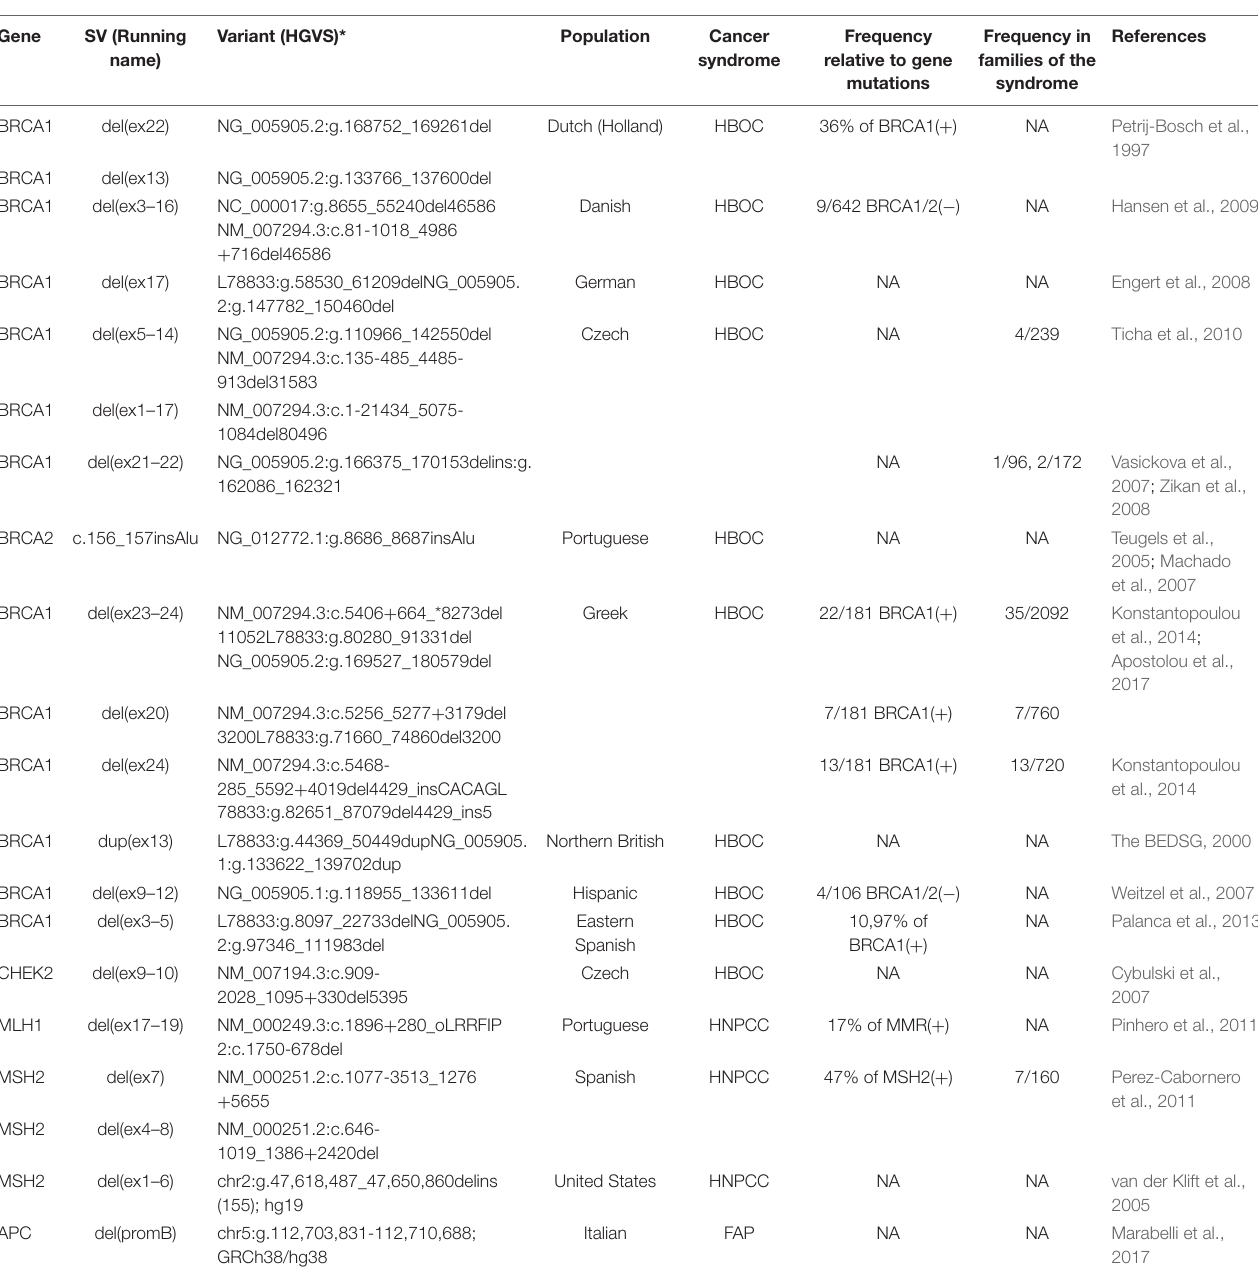
TABLE 1 | Examples of founder SVs and frequencies in various populations. Gene SV (Running